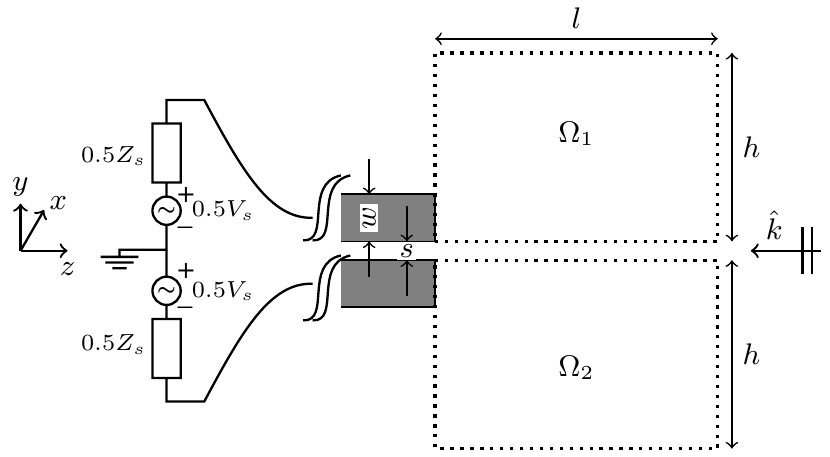
Figure 1. The design domain Ω = Ω 1 ∪ Ω 2 is connected to a source V s , with an internal impedance Z s , through a differential-fed strip line at the center of the left side. Each of the domains Ω 1 and Ω 2 has an area h × l where a metallic material (copper) is to be distributed to achieve the design